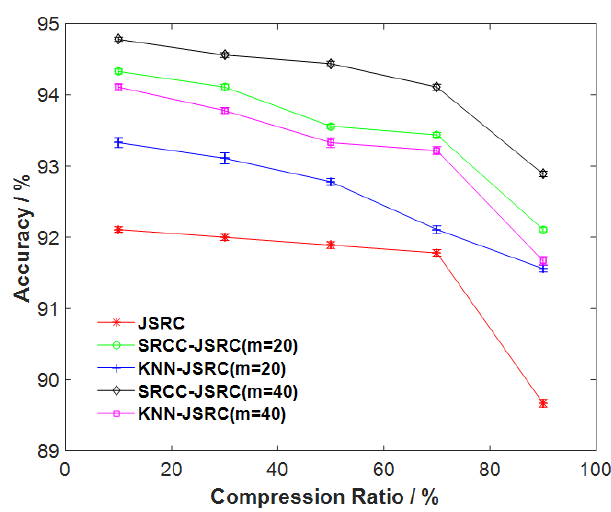
Figure 2. Comparative results of the different gait-classification performances based on the different compression ratios.